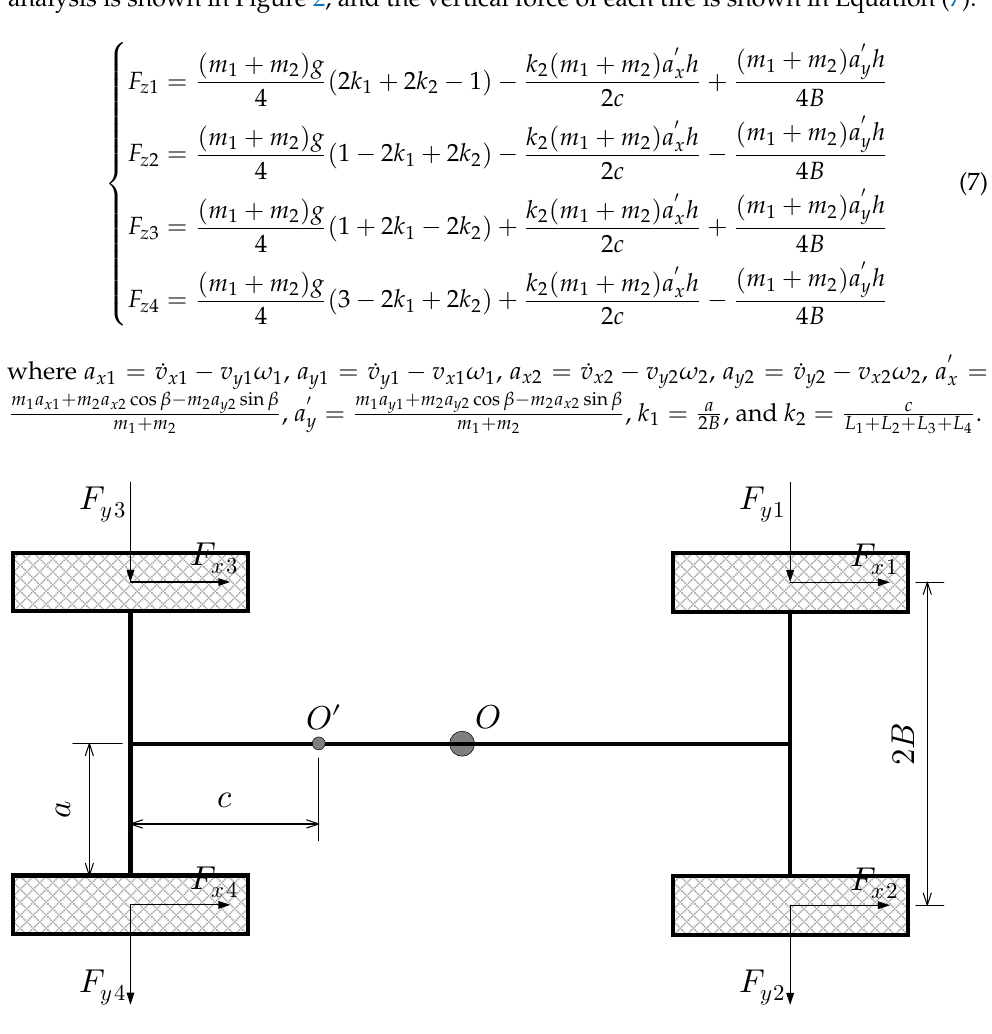
Figure 2. Articulated vehicle vertical force analysis. The lateral and longitudinal linear velocities at the centre of each wheel are shown in Equations (8) and (9),